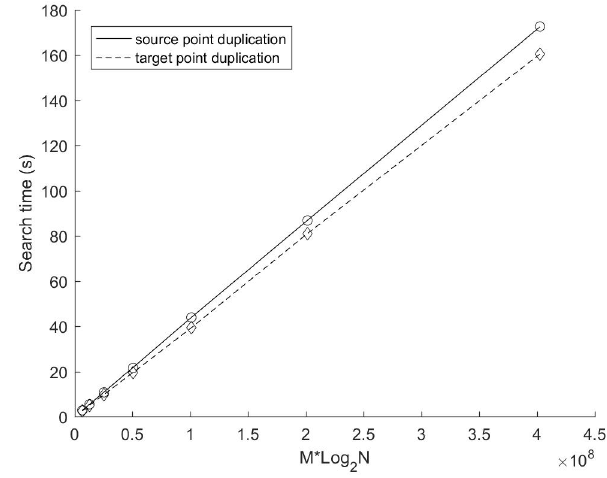
Figure 8. Search time with different number of target points.